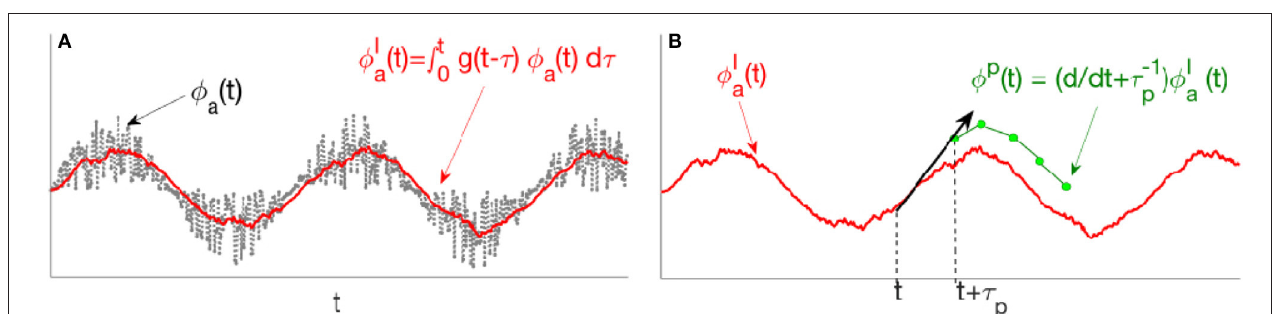
FIGURE 3 | Schematic of stages in the predictor given by Equation (47). (A) The input signal φ a ( t ) first passes through G J a ( s ), a second-order low-pass convolution filter. (B) The filtered signal φ I a ( t ) then passes through H J ba ( s ), where, linear extrapolation over a prediction time τ p yields the predicted signal φ P ( t ).